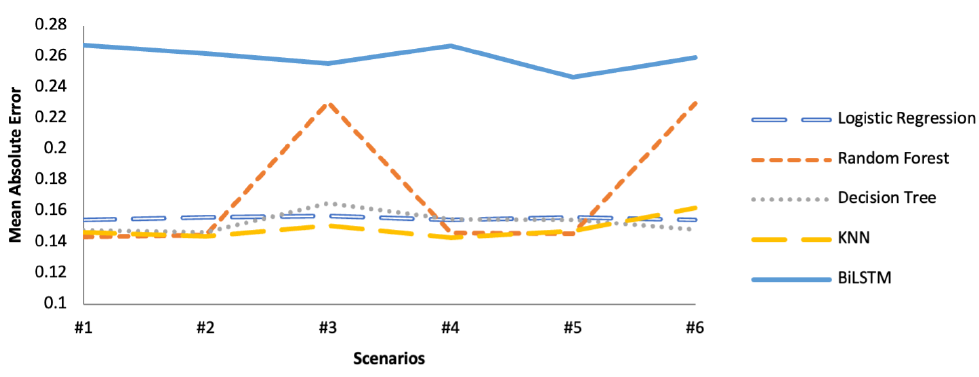
Figure 9. Algorithms’ Mean Absolute Error for the regression method (Y = “Sentiment”).